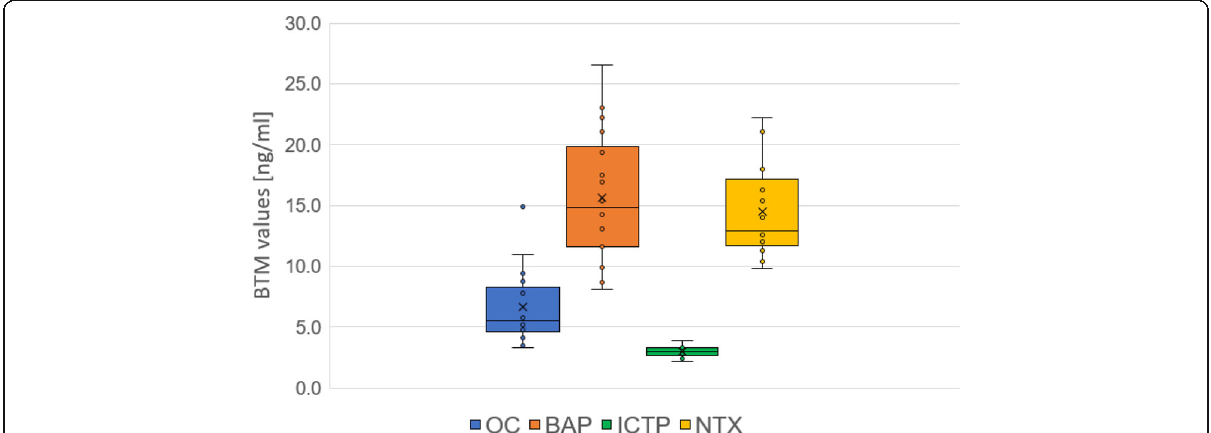
Fig. 3 The overview on BTM values are shown. The bone turnover markers measured are osteocalcin (OC), bone-specific alkaline phosphatase (BAP), pyridinoline cross-linked carboxyterminal telopeptide of type I collagen (ICTP), and crosslinked N-telopeptide of type I collagen